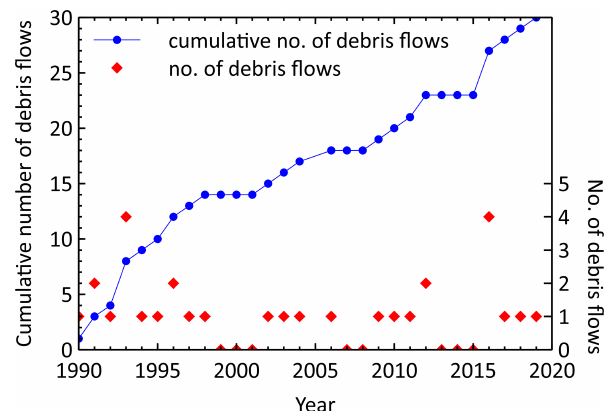
Figure 6. Number of debris flows occurred in each year and cu- mulative number of events in the observation period. There are no years with missing data: when the monitoring instrumentation was not working, debris-flow occurrence was documented through field